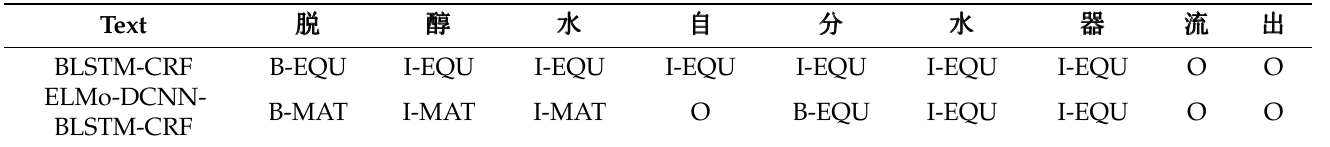
Table 6. An example of model accuracy